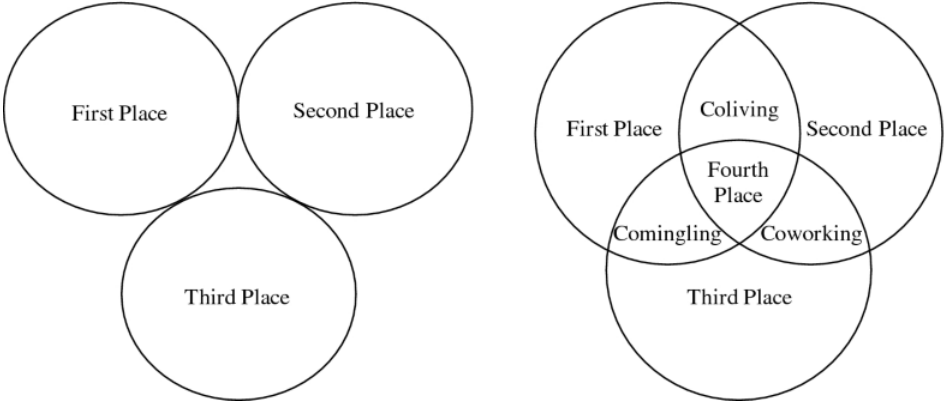
Figure 1. “Places before ( left ) and in ( right ) the knowledge economy” according to Morrison.